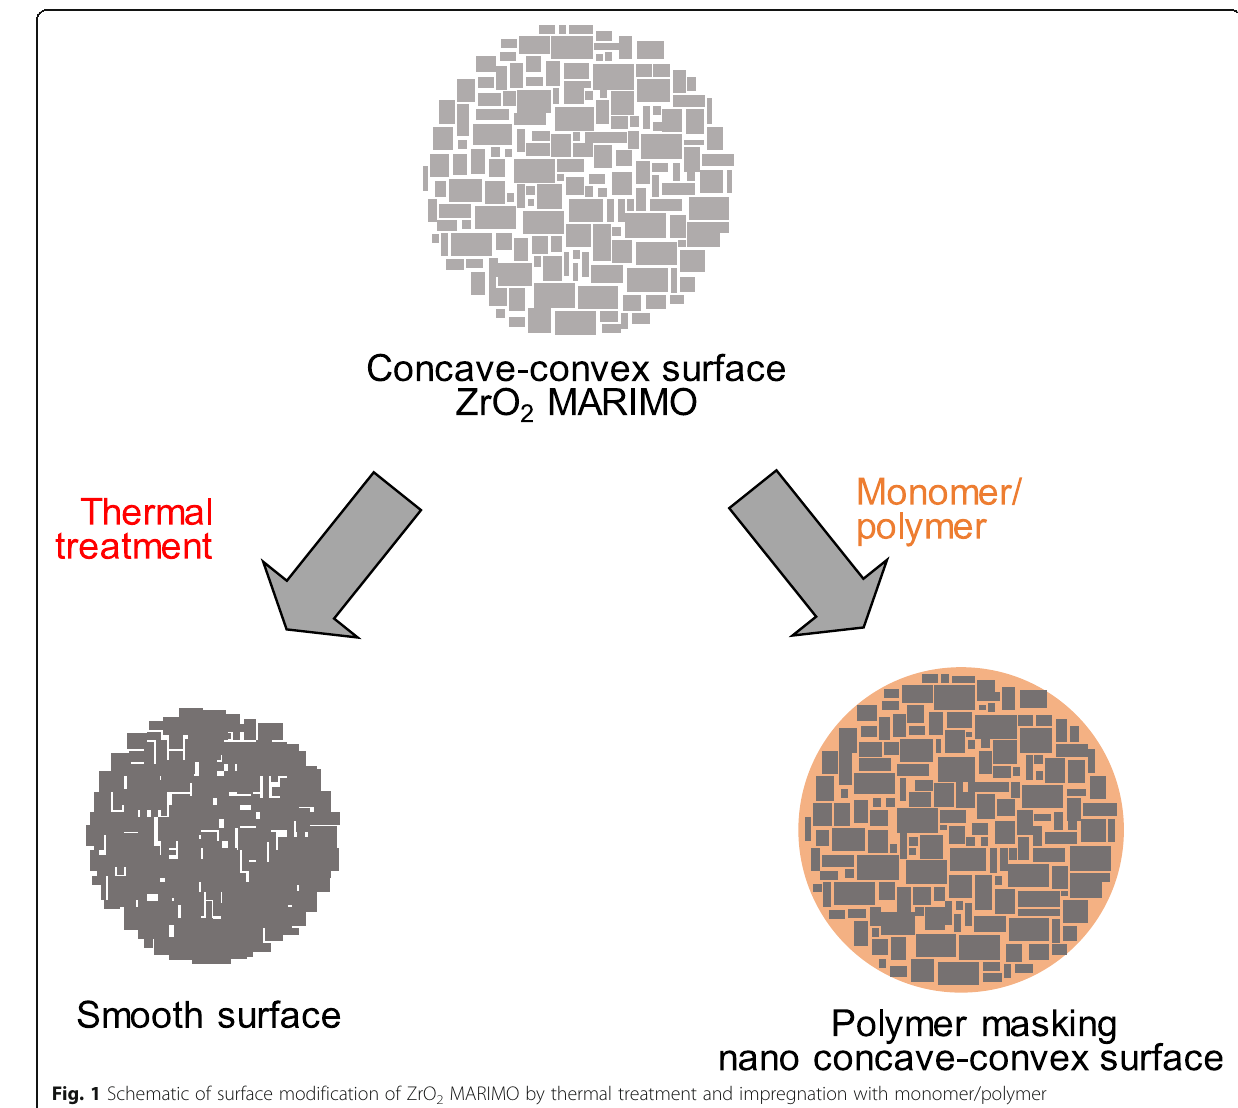
Fig. 1 Schematic of surface modification of ZrO 2 MARIMO by thermal treatment and impregnation with